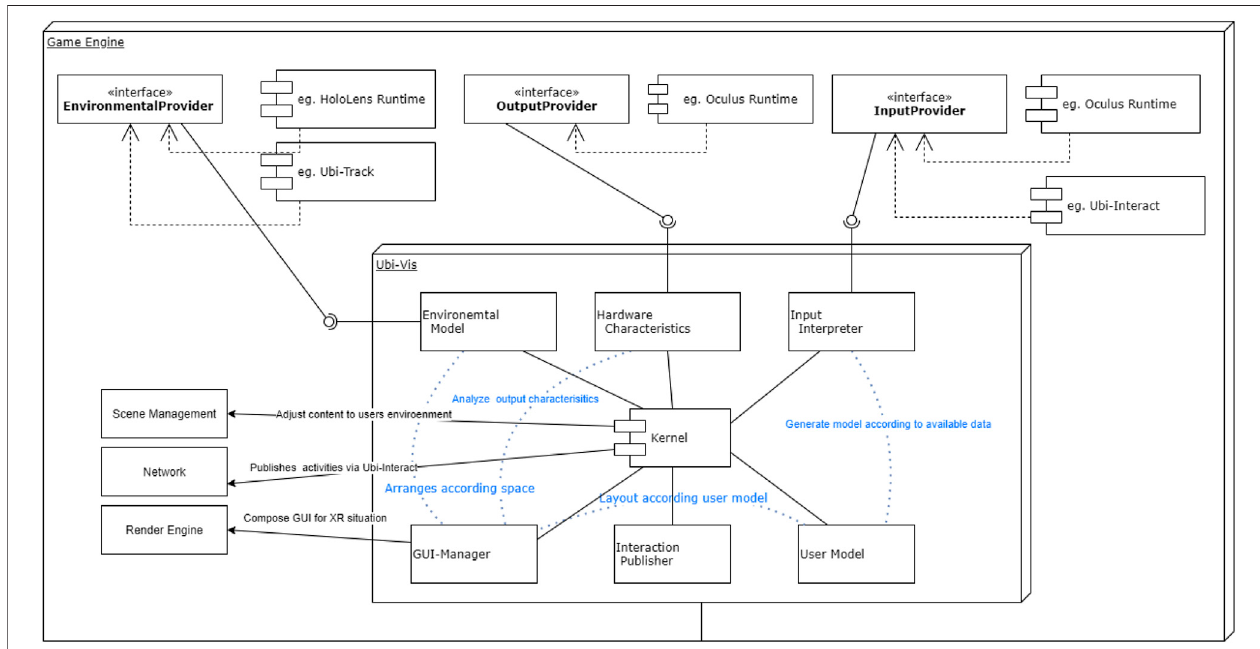
FIGURE 4 | Architecture overview of UbiVis in combination with a game